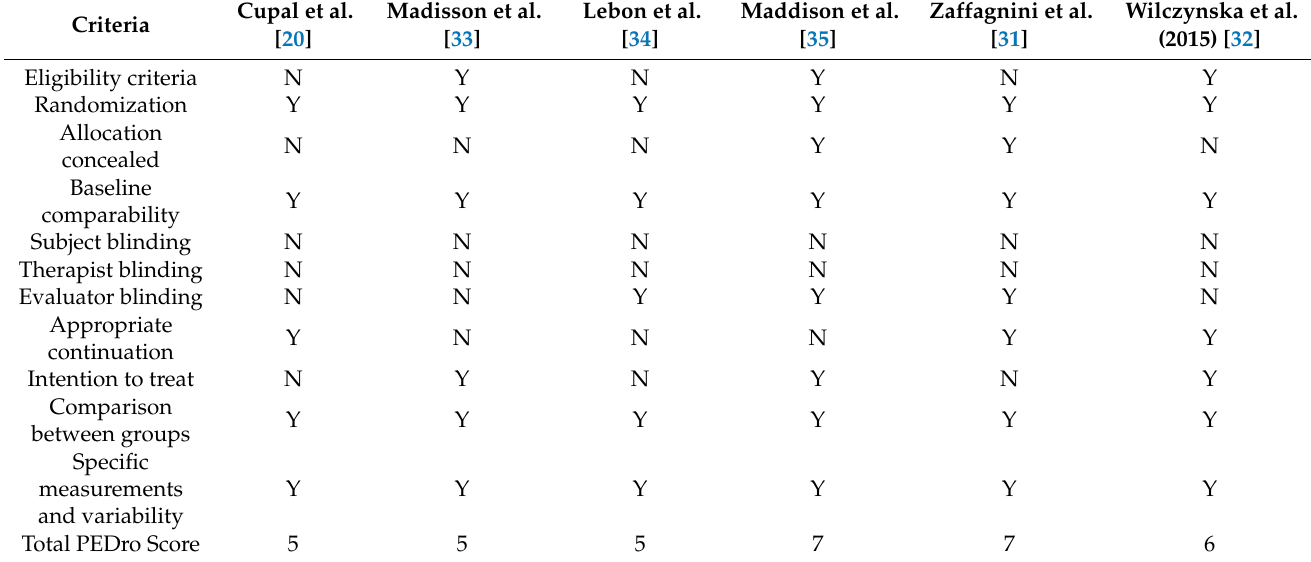
Table 3. Methodological quality according to the PEDro